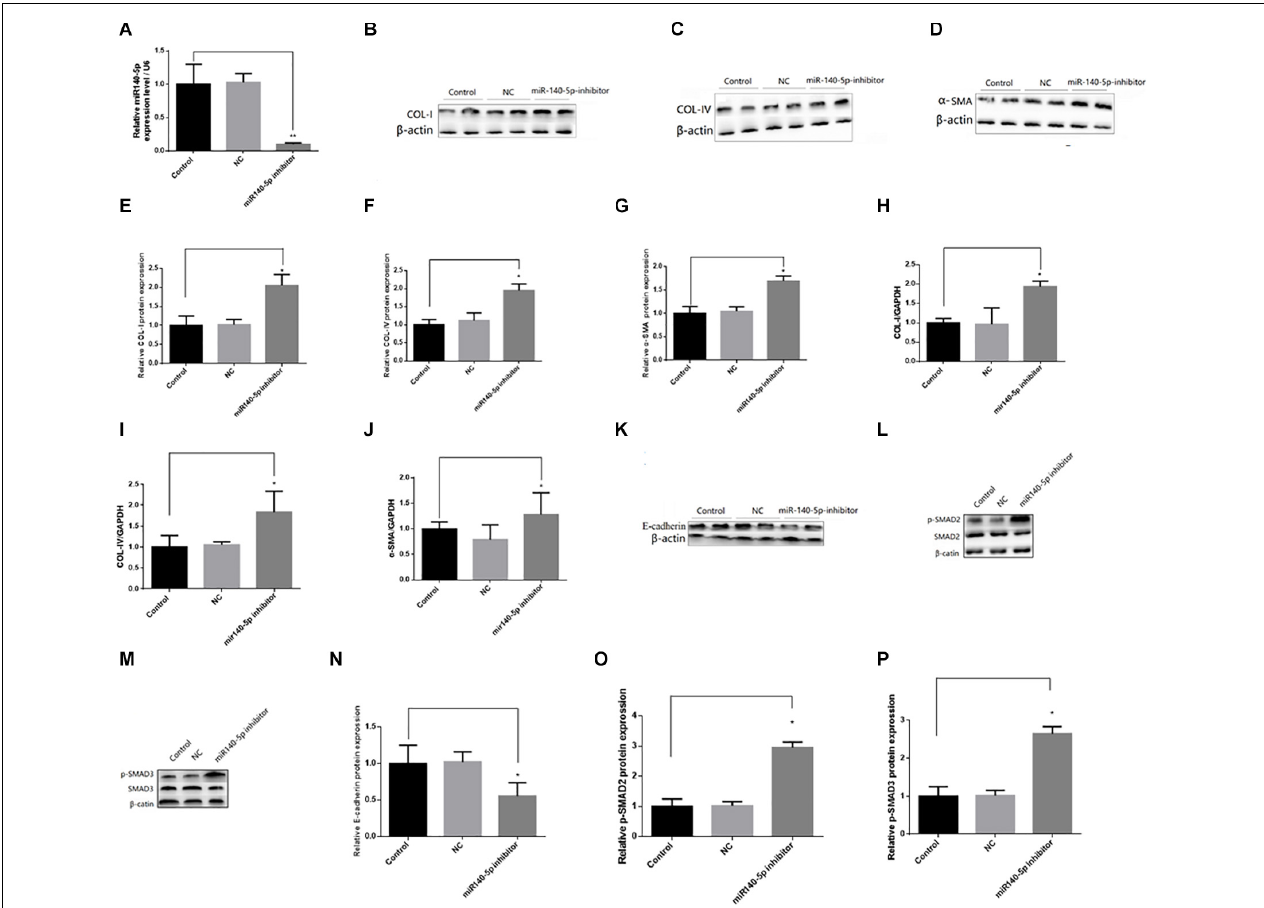
FIGURE 3 | Knockdown of miR140-5p aggravated TGF- β 1-induced fibrosis and EMT in HK2 cells. HK2 cells were transfected with miR140-5p inhibitor (20 nmol/L) or inhibitor negative control (NC, 20 nmol/L) for 24 h and then treated with TGF- β 1 (5 ng/ml) for 48 h. (A) the expression level of miR140-5p in HK2 cells transfected with miR140-5p inhibitor. The protein expression of COL-I (B) , COL-IV (C), α -SMA (D) were examined by Western blotting in HK2 cells. (E–G) The bar chart showed the ratio of quantitative band density measurements of COL-I, COL-IV, and α -SMA to β -actin, respectively. The mRNA expression of COL-I (H) , COL-IV (I) , and α -SMA (J) were examined by RT-qPCR in HK2 cells. The protein expression of E-cadherin (K) , p-SMAD2/SMAD2 (L) , p-SMAD3/SMAD3 (M) were examined by Western blotting in HK2 cells. β -actin was detected as a loading control. (N–P) The bar chart showed the ratio of quantitative band density measurements of E-cadherin, p-SMAD2, p-SMAD3 to β -actin, respectively. Data was presented as mean ± SD of three experiments. Control: no transfection treatment, Negative control (NC): cells transfected with scrambled oligonucleotide. ∗ P < 0.05 versus Control; ∗∗ P < 0.01 versus